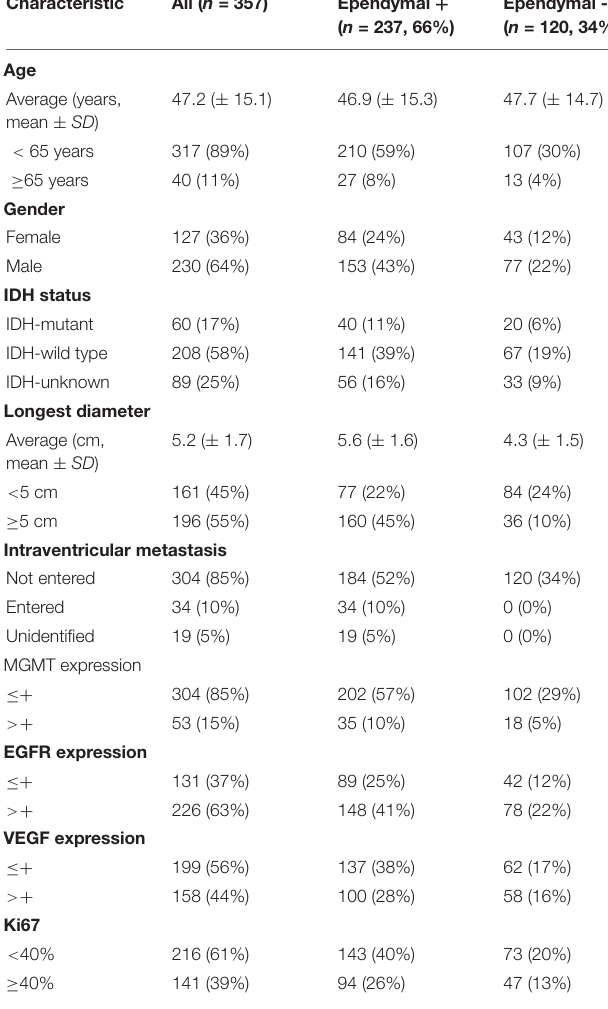
TABLE 1 | Characteristics of the study